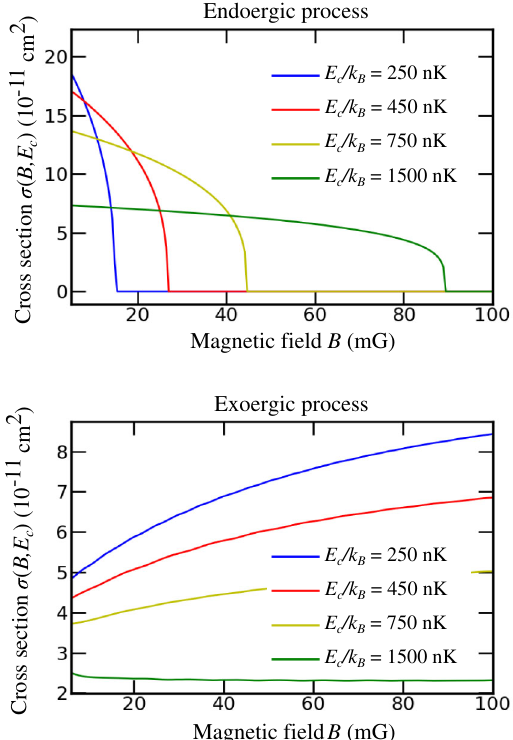
FIG. 6. Scattering cross sections for endoergic SE (top) and ¼ 2 and Rb in the exoergic SE (bottom) for Cs in the state m F; Cs ¼ 0 . The cross sections are plotted for four different state m F; Rb (250, 450, 750, and 1500 nK). In the fixed collision energies E c ≤ μ B= 4 , endoergic SE, the energy condition is underlined: If E c B the collision is forbidden, and therefore, the cross section drops to